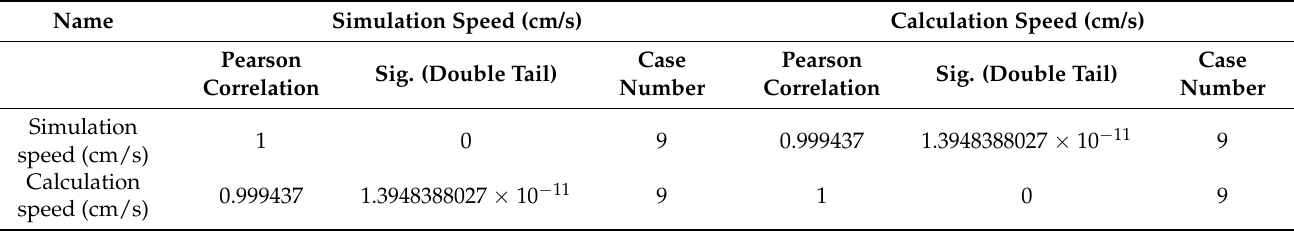
Table 8. Correlation between the simulation and actual calculation